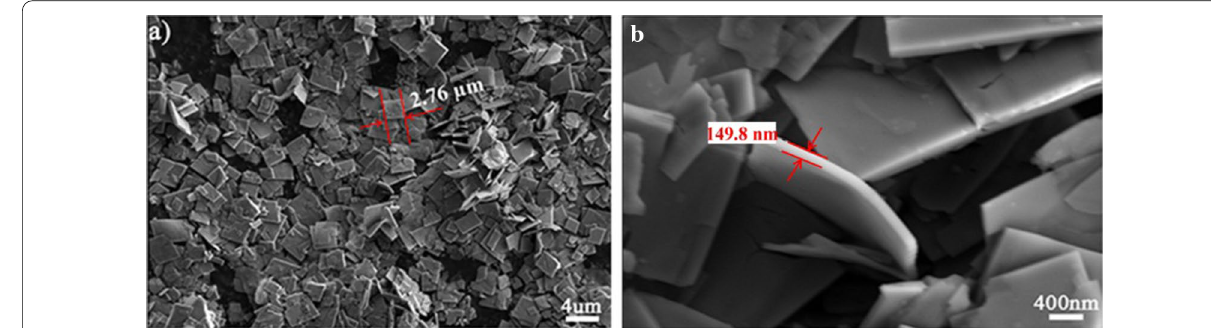
Fig. 8 SEM images of EuCrMo 6 microflakes